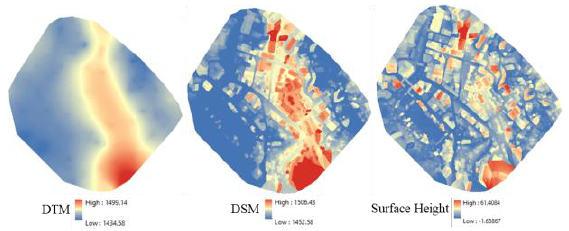
Figure 2. Generated DTM, DSM, and surface heights used in the computation of building and vegetation heights in Session Road.